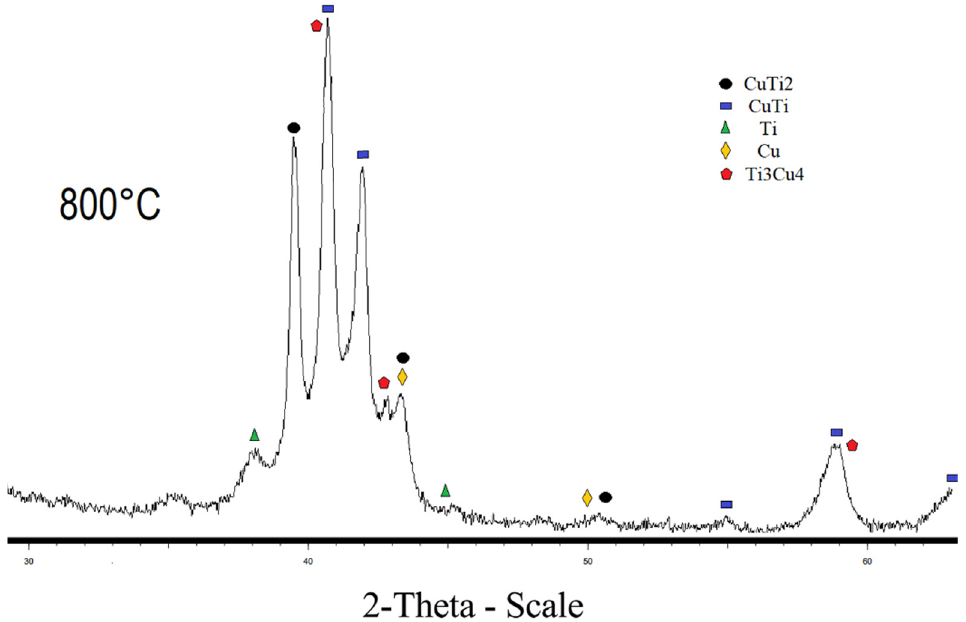
Figure 3. X-ray pattern of specimen obtained at 800 °C .